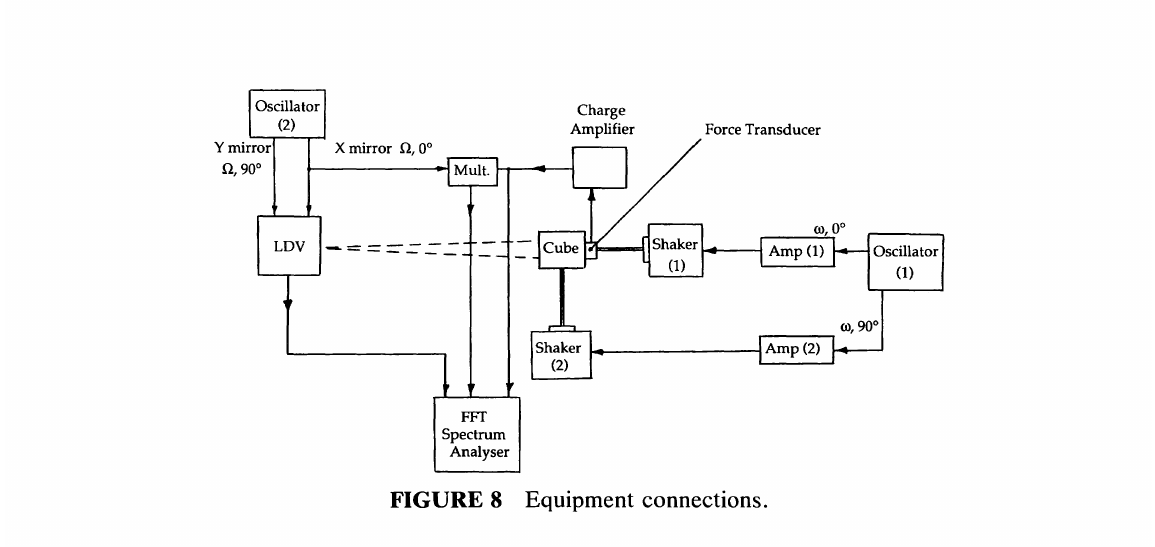
FIGURE 8 Equipment